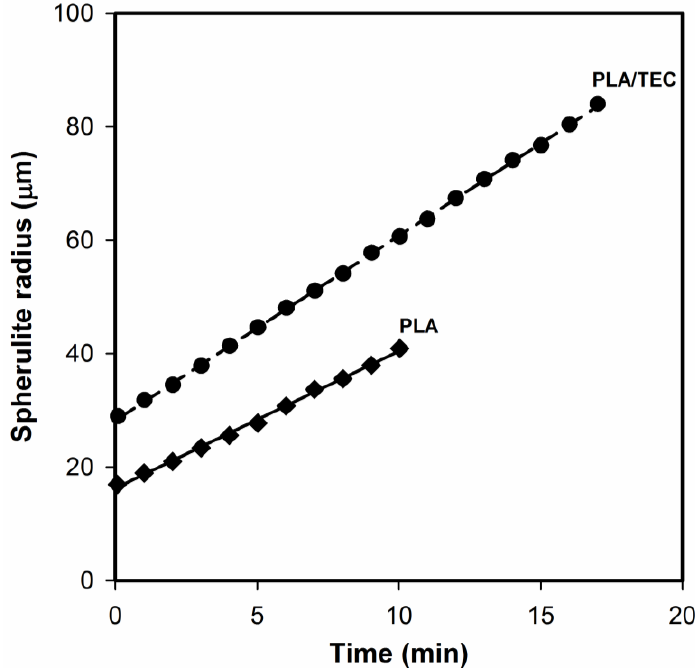
Figure 2. Changes in spherulite radius as functions of time for neat and plasticized PLA.